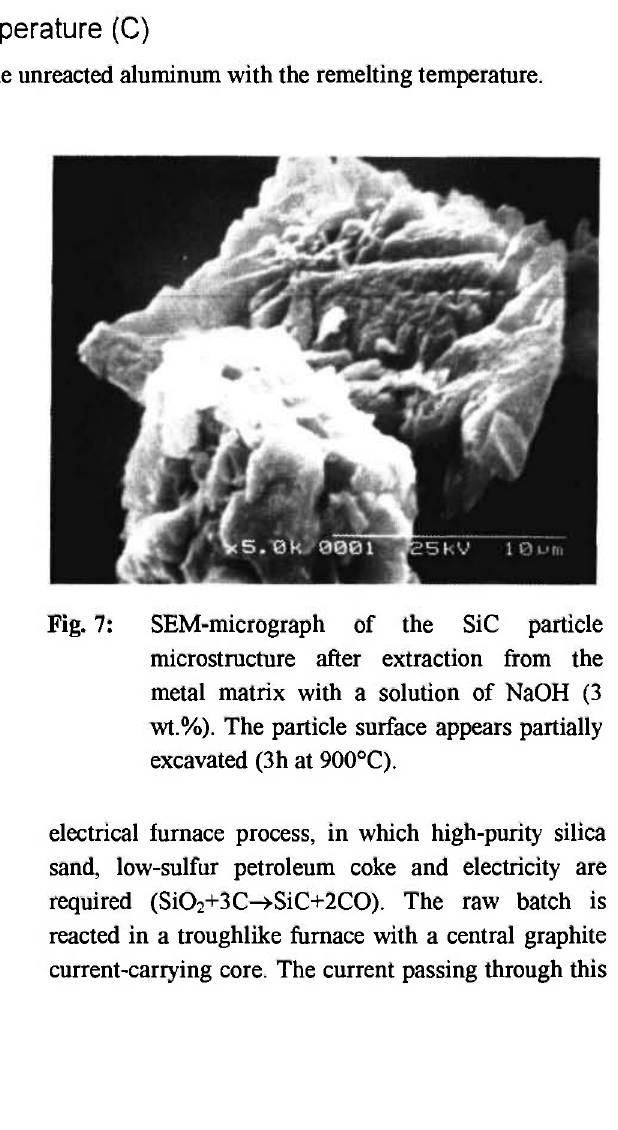
Fig. 6: Equilibrium concentration (mole-%) of the unreacted aluminum with the remelting temperature. elevated dissolution of the SiC grains was observed when the remelting treatment was performed up to 800°C.